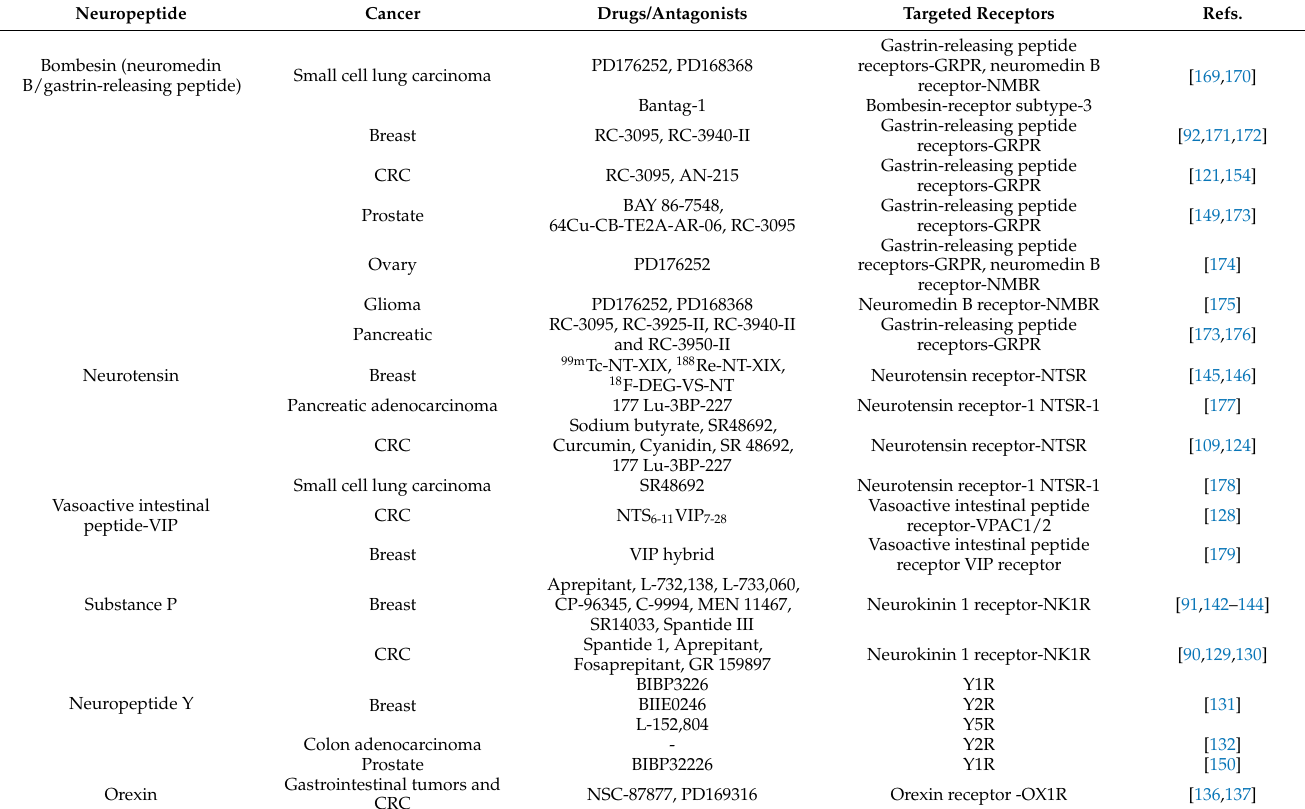
Table 3. List of neuropeptides, corresponding receptors, and relative drugs/antagonists useful for preventing cancer